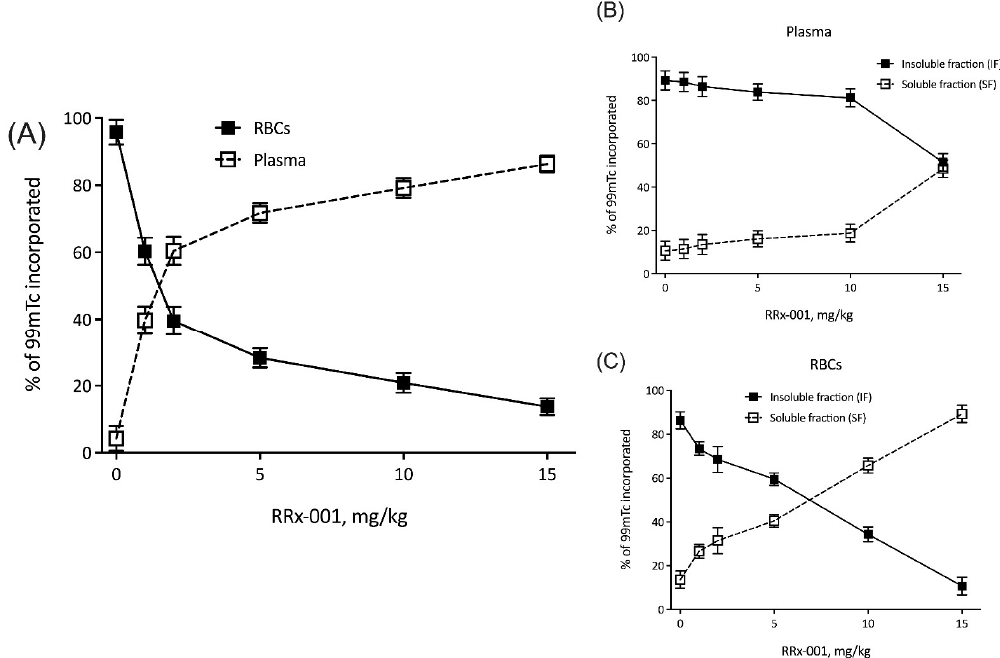
Figure 1. RRx-001 localizes to RBCs. Shown here are percent of 99m Tc incorporated into ( A ) plasma and RBCs, ( B ) insoluble and soluble fractions of plasma, and ( C ) insoluble and soluble fractions of RBCs, all as a function of RRx-001 dose (mg/kg).